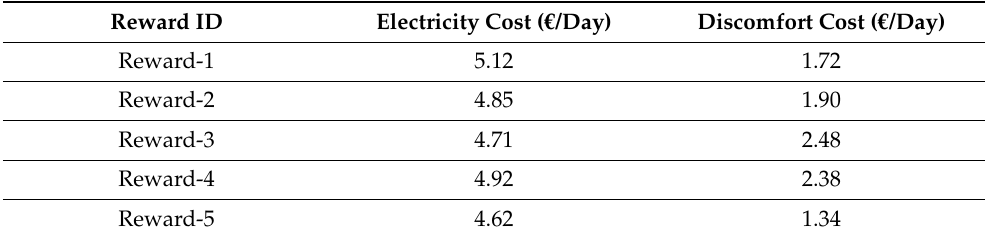
Table 6. Comparison of electricity cost for different reward